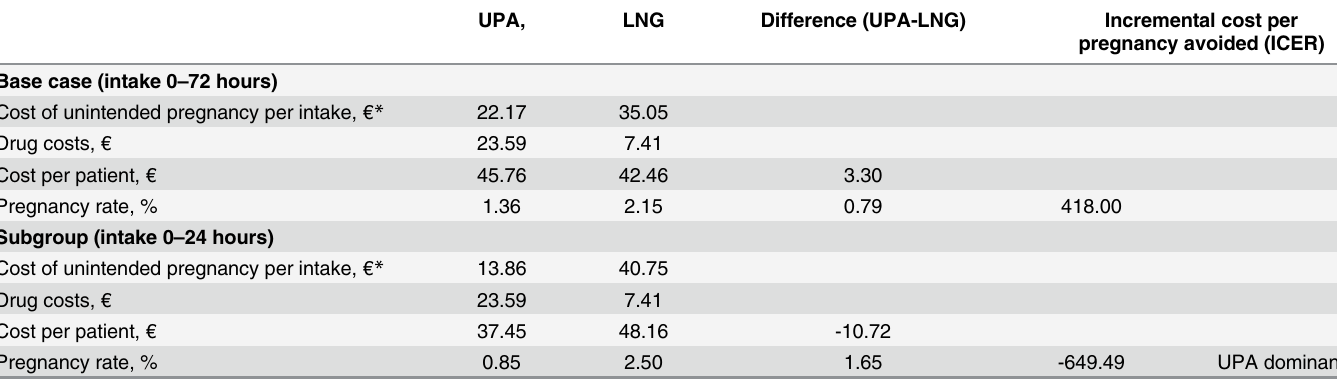
Table 5. Incremental cost and effectiveness of ulipristal acetate versus levonorgestrel. UPA dominant, more effective at lower cost; UPA, LNG